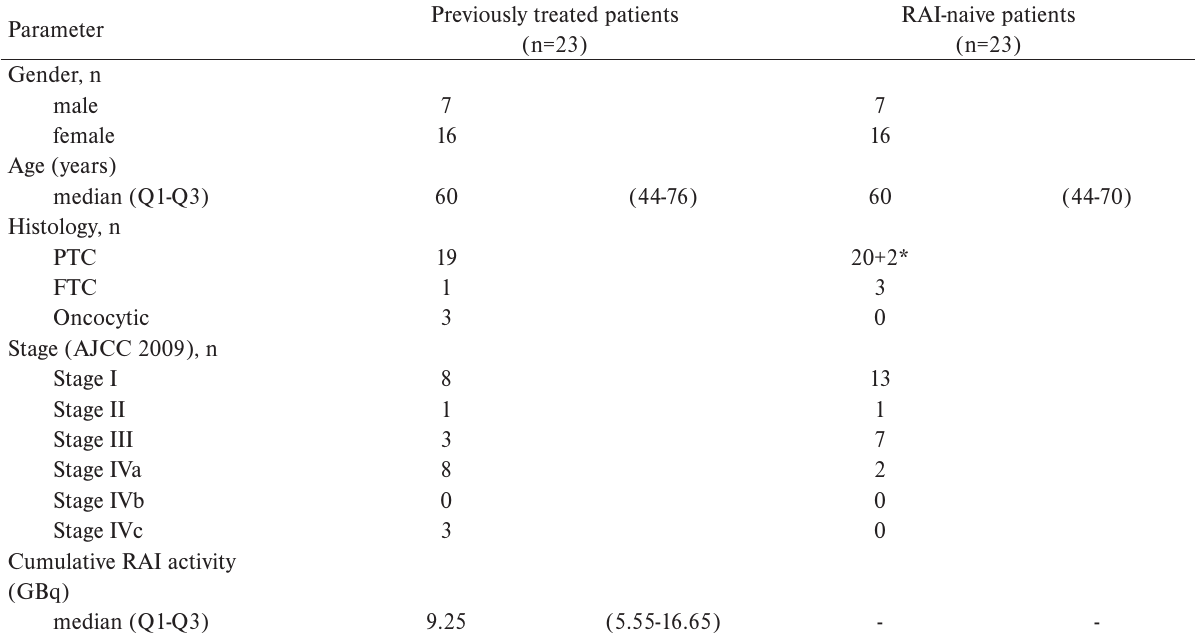
Table 1. Characteristics of patients with radioiodine administration history and their RAI-naive couterparts.